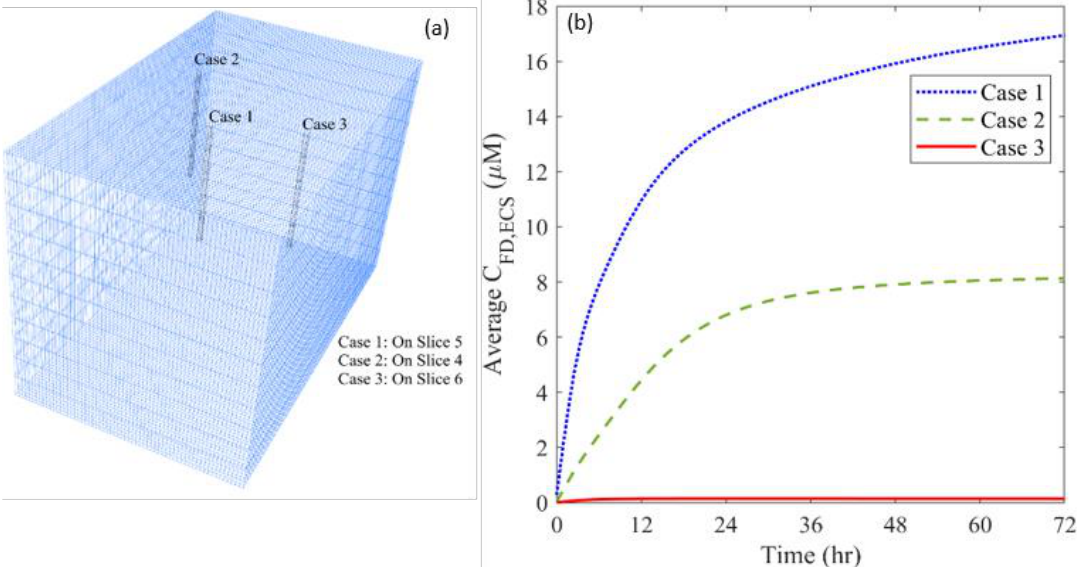
Figure 16. ( a ) Location of different infusion sites of cell volume fraction, and ( b ) its impact on the time course of free temozolomide concentration in the brain tumor.